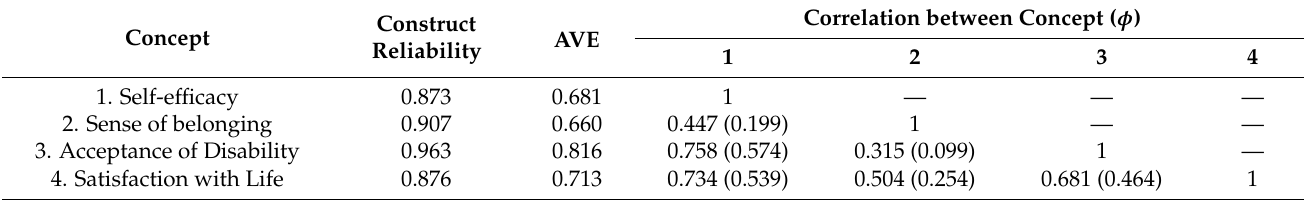
Table 1. Construct reliability and AVE of measurement model Construct